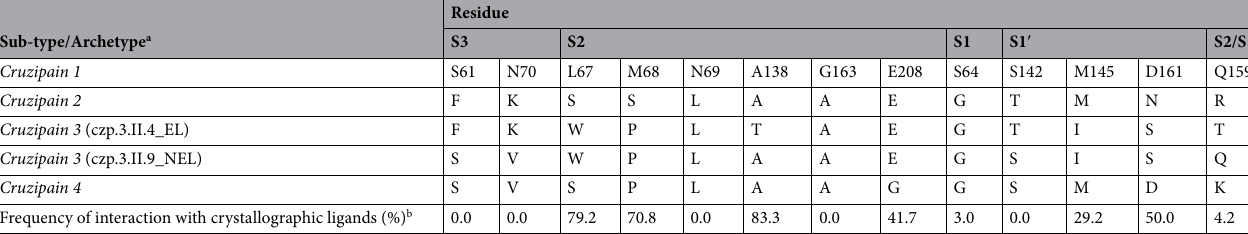
Table 2. Amino acids substitutions in the active site of cruzipains and frequency of interactions of each position with cruzain ligands. a We modeled one or two isoforms from each cruzipain sub-type, corresponding to sequences from czp.2.II.6_EL, czp.3.II.4_EL,czp.3.II.9_NEL and czp.4.II.7_NEL. b Intermolecular